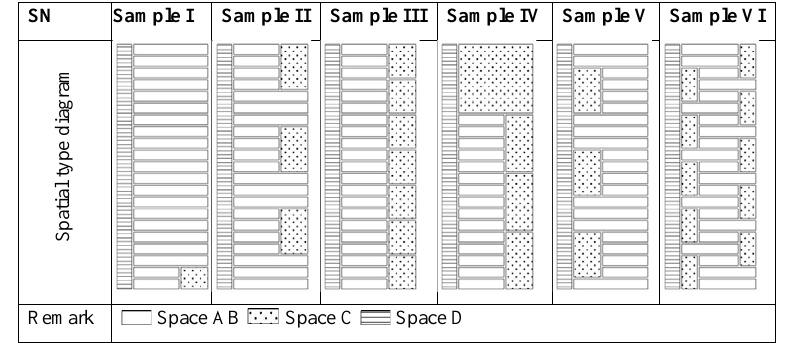
Table 2 Diagrams for space types AB, C and